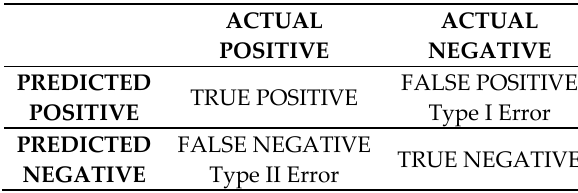
Figure A3. Guide for interpretation of confusion matrices.